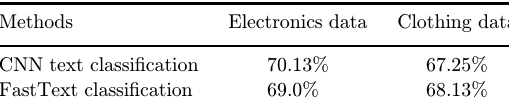
Table 3. Performance of helpful identi¯cation